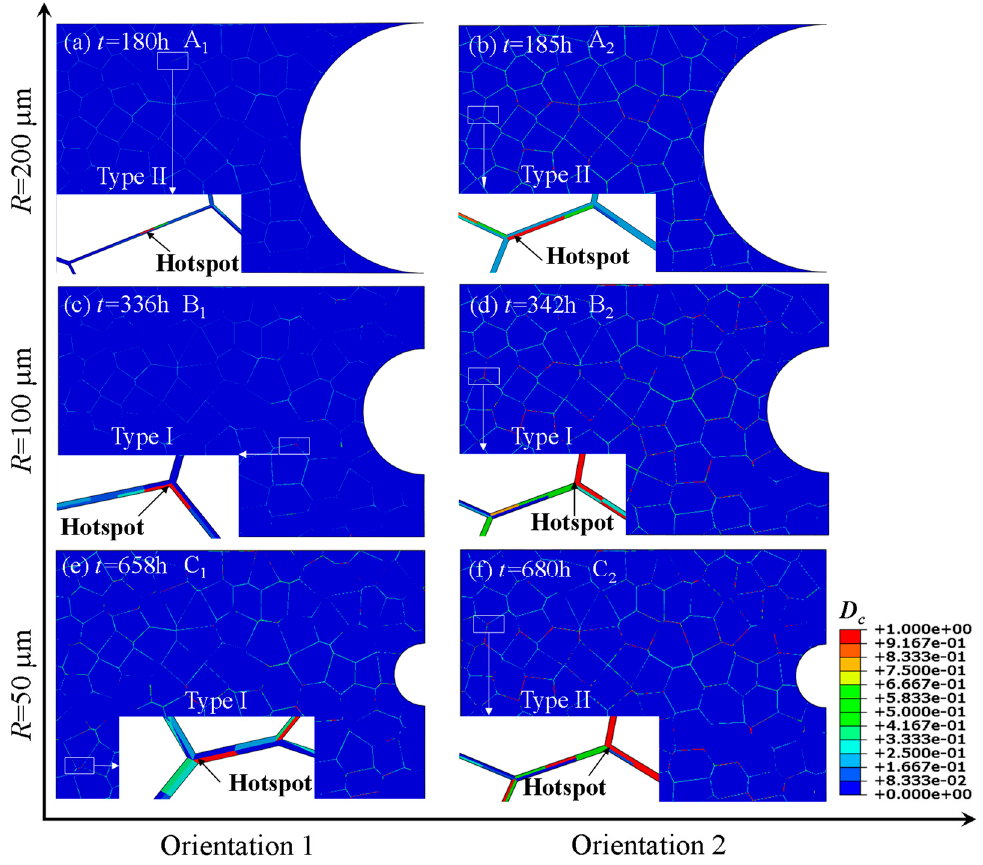
Figure 4. Contour plots of creep damage D c : ( a ) Model A 1 ( R = 200 μ m, Orientation 1); ( b ) Model A 2 ( R = 200 μ m, Orientation 2); ( c ) Model B 1 ( R = 100 μ m, Orientation 1); ( d ) Model B 2 ( R = 100 μ m, Orientation 2); ( e ) Model C 1 ( R = 50 µ m, Orientation 1); ( f ) Model C 2 ( R = 50 µ m, Orientation 2).